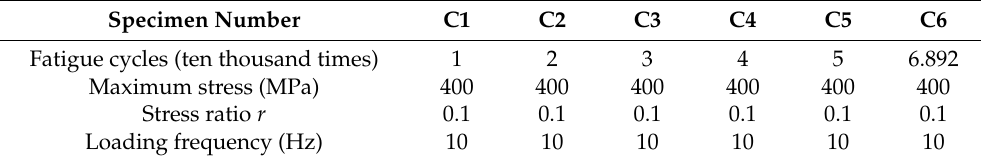
Table 3. Fatigue loading parameters of the SLM 316L stainless steel